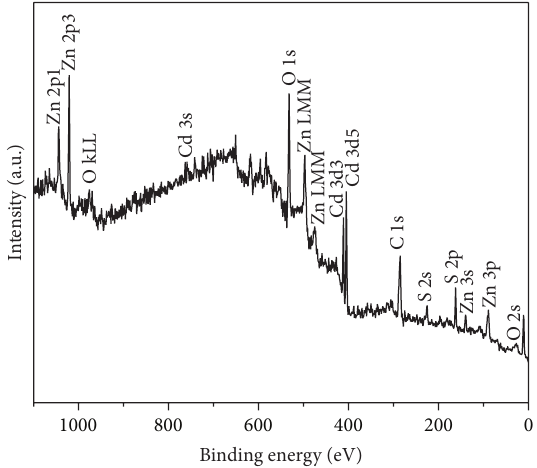
Figure 6: XPS of ZnO/CdS/BC hybrid fiber (50%).